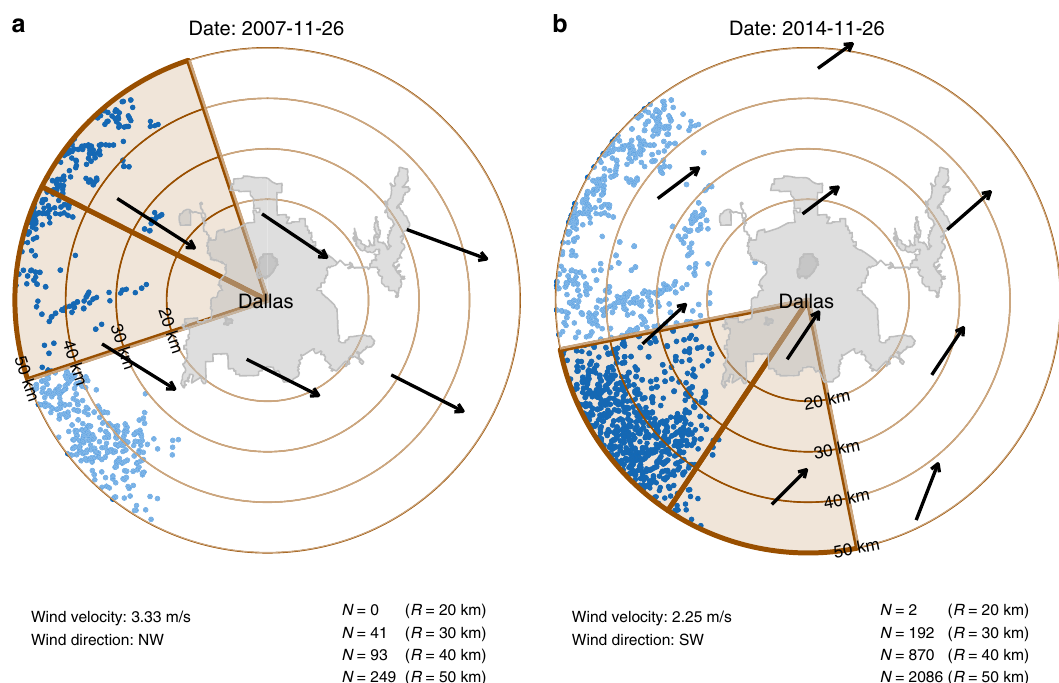
Fig. 3 Methods to calculate the number of UOGD wells positioned upwind of the RadNet monitor in two example days. The example monitor is positioned at Dallas, TX. a The calculation of Nov-26-2007; b The calculation of Nov-26-2014.Due to the inaccessibility of the monitor ’ s exact location, we used the geometric center of the city of Dallas, TX as a proxy. Based on daily wind direction (black arrows), we created the circular sectional buffer with a radius of 20 km and angle of 90 degrees. We created a series of buffers with radiuses ranging from 20 to 50 km, in order to investigate the scale dependency. We used the same method to count the daily number of COGD wells upwind of RadNet